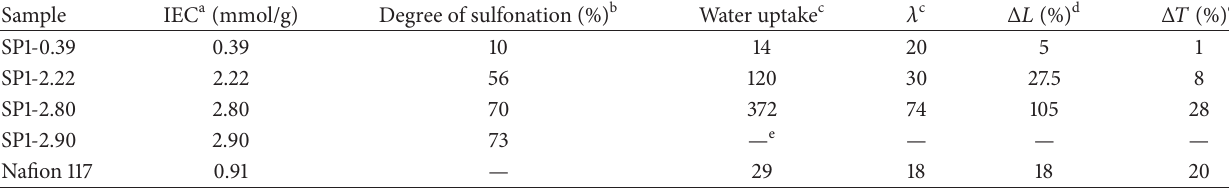
Table 1: IEC, water sorption, and dimensional stability of SP1 membranes.